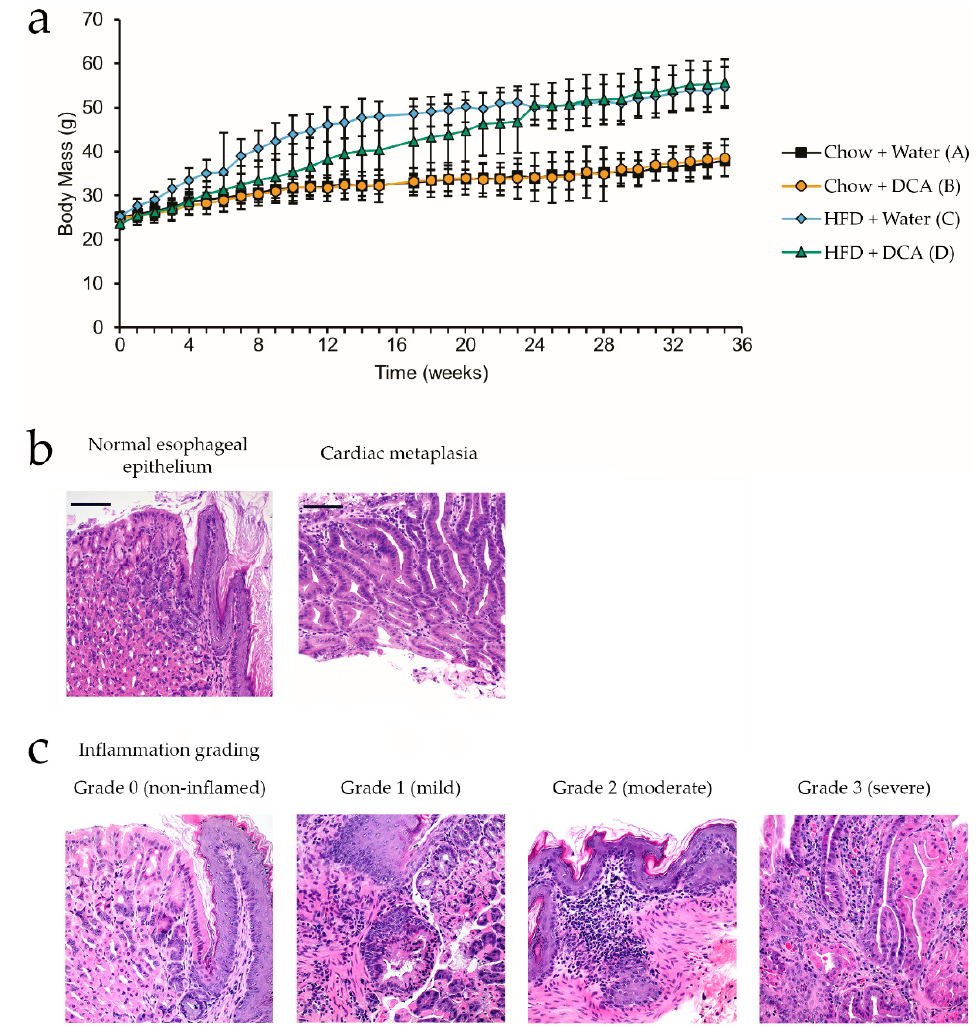
Figure 1. Chronic high-fat and / or bile acid dietary intervention in wild-type mice induces chronic inflammation and cardiac metaplasia development at the gastroesophageal junction. C57BL / 6 mice ( n = 11 per group) were given +/ − high-fat diet (HFD) and +/ − 0.2% deoxycholic acid (DCA) over a 9 month period, and gastroesophageal junction tissue morphology evaluated in hematoxylin & eosin (H&E) stained sections for inflammation and epithelial changes. ( a ) Body weight over time for each of the four groups. Values are mean ± SD; ( b ) Example esophageal epithelium morphology for normal and cardiac metaplasia. ( c ) Example inflammation grading. (200×; scale bar 100 µm).